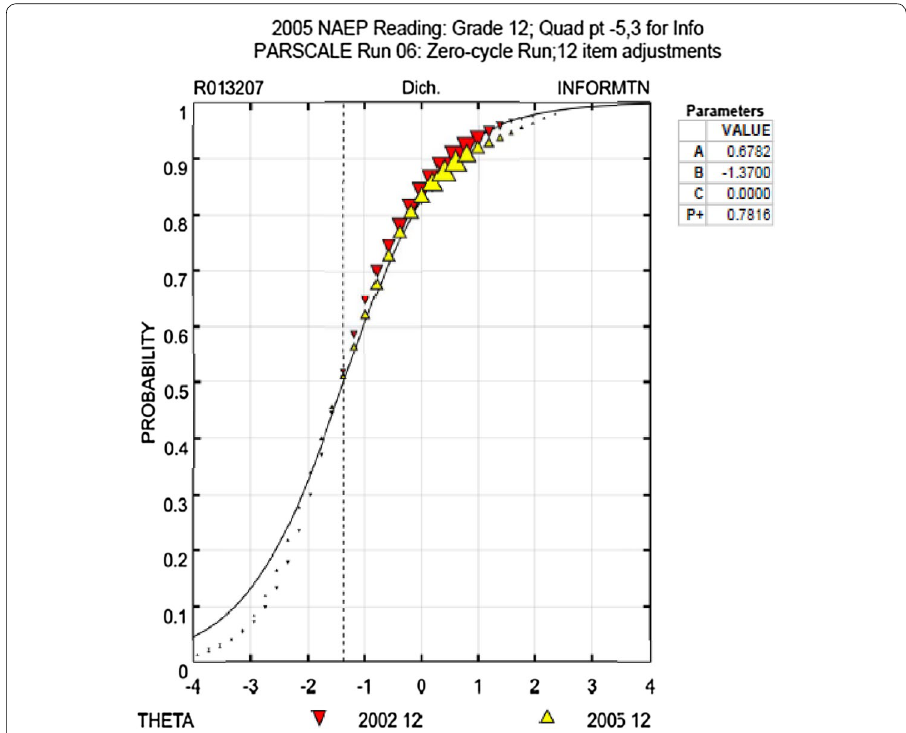
Fig. 5 Operational item fit plot for a 2005 reading grade 12